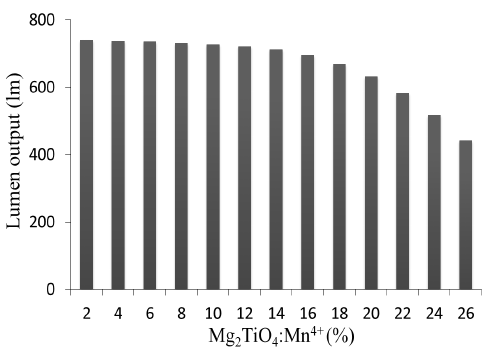
Fig. 6: The luminous (cid:29)ux of WLEDs as a function of Mg 2 TiO 4 :Mn 4+